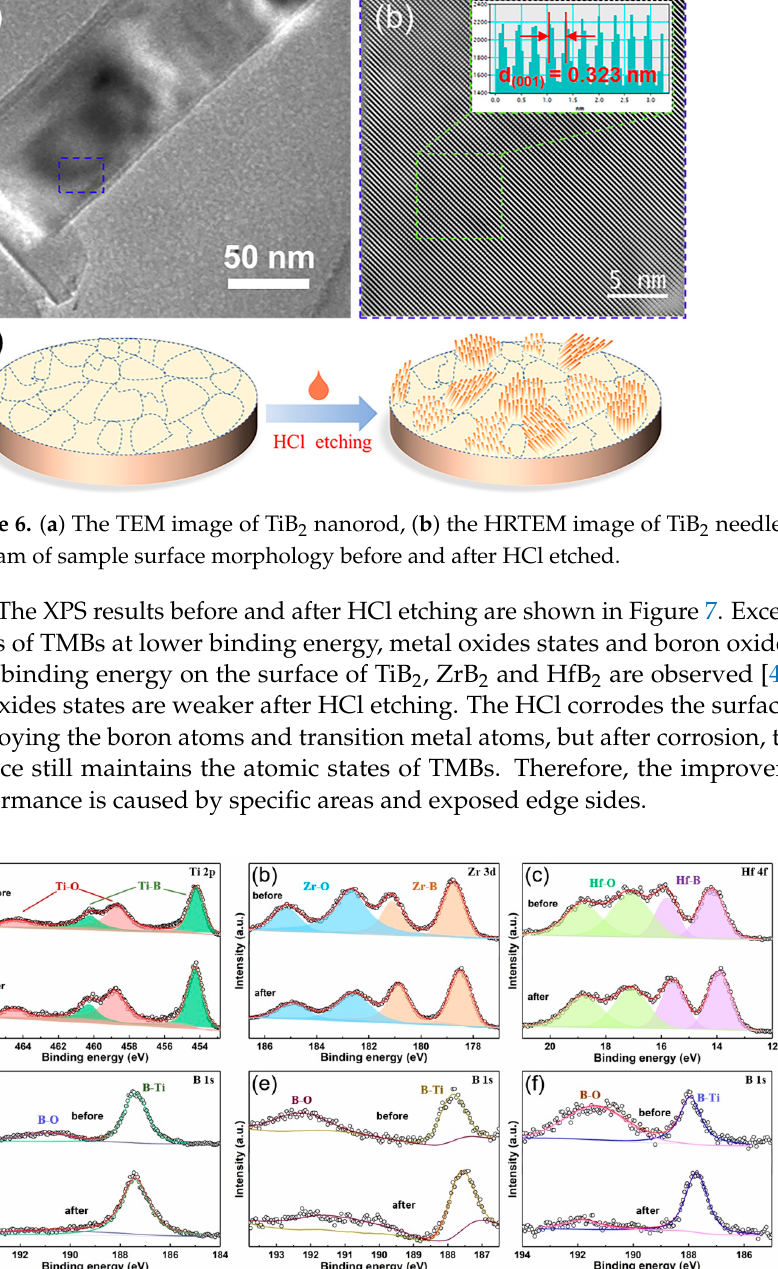
Figure 7. The XPS spectra of TiB 2 ( a ) Ti 2p, ( d ) B 1s, ZrB 2 ( b ) Zr 3d, ( e ) B 1s and HfB 2 ( c ) Hf 4f, ( f ) B 1s before and after HCl etched.